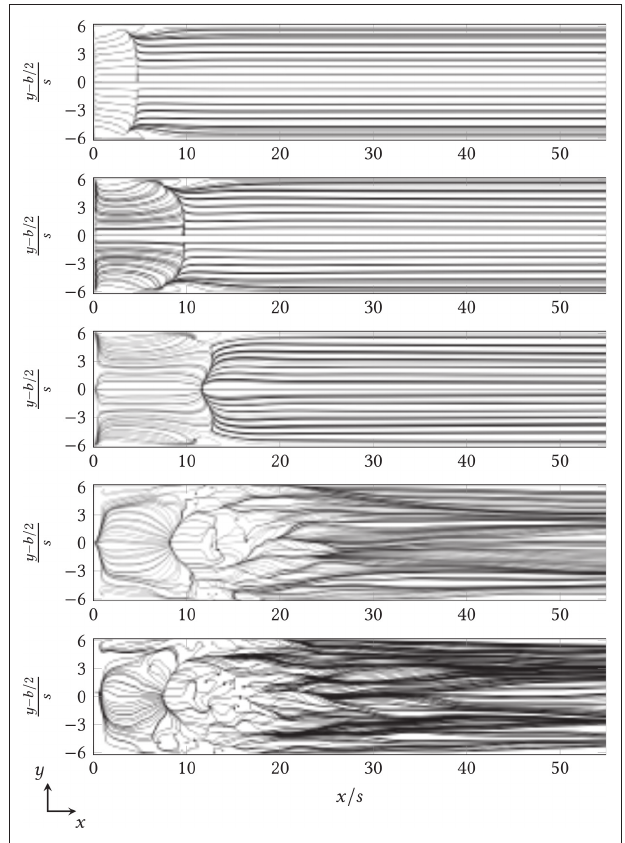
FIGURE 6 | Instantaneous progression of streamlines above the surface of the lower cover glass behind the backward-facing step (at x / s = 0) for ˙ V = { 20,50,80,120,150 } mL min − 1 (top to bottom) in plan view. The channel width (shown here as y -axis) was also normalized to the step height s and centered, according to